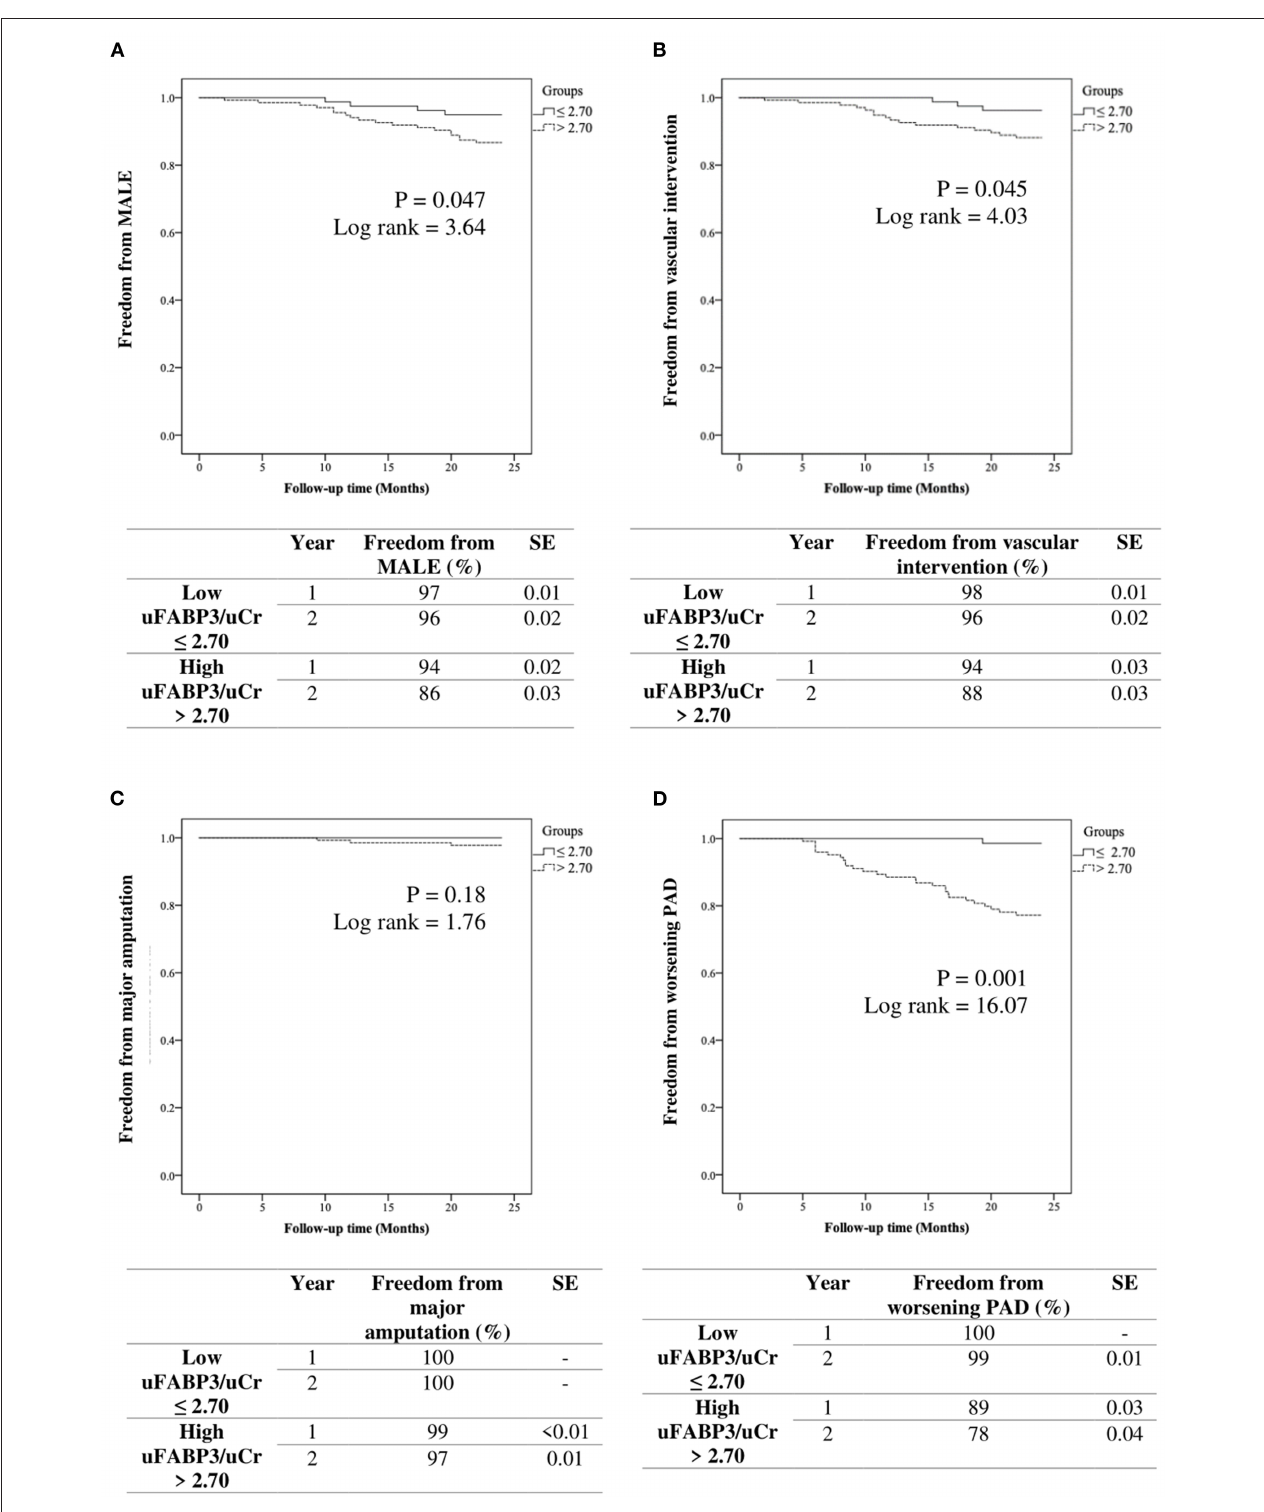
FIGURE 1 | Kaplan-Meier analysis of event free survival rates in patients with low vs. high urinary fatty acid binding protein 3 normalized to urinary creatinine (uFABP3/uCr) for (A) MALE (major adverse limb event), (B) vascular intervention, (C) major amputation, and (D) worsening PAD (ankle brachial index drop ≥ 0.15). SE (standard